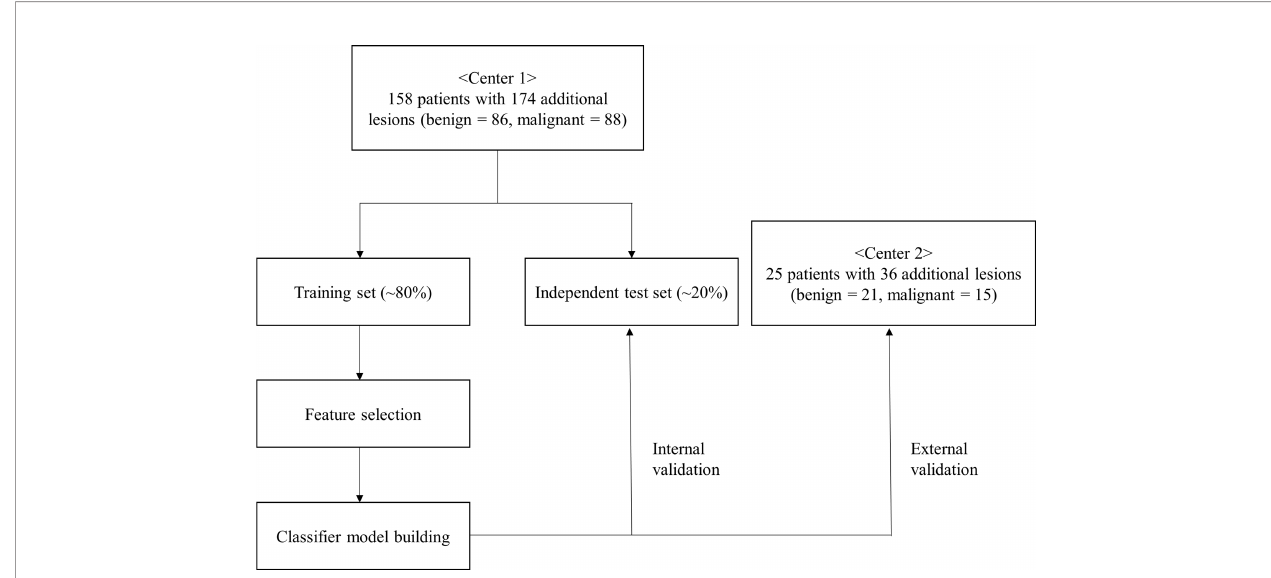
FIGURE 1 | The work fl ow of the